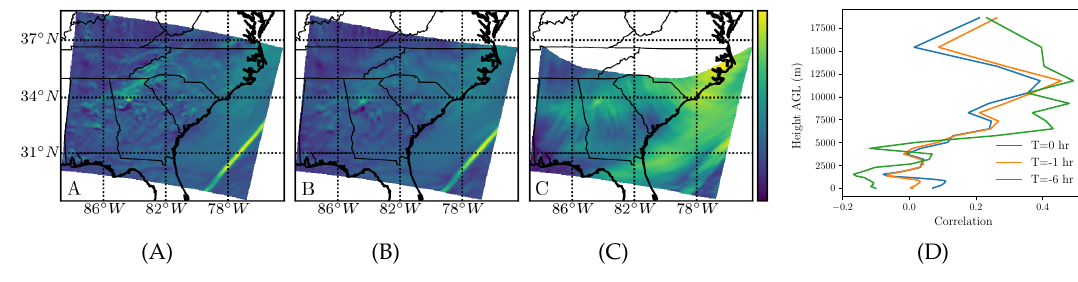
Figure 6. The same as in Figure 4, but for ozone (O 3 ).